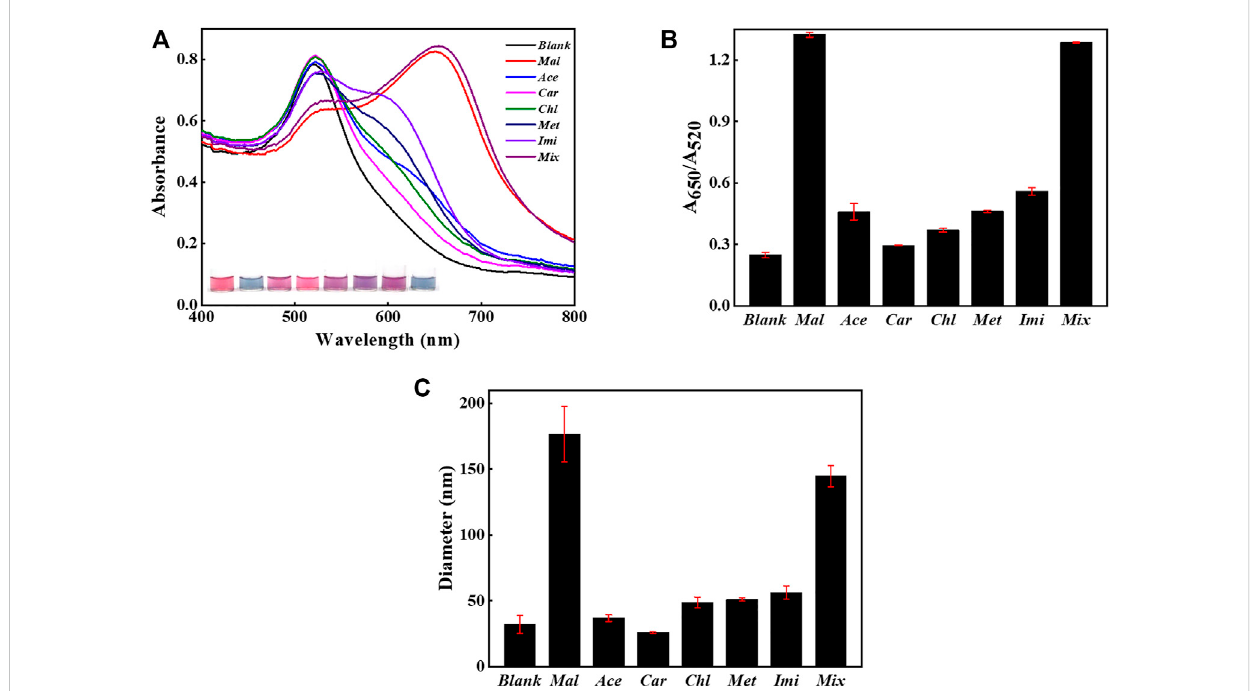
FIGURE 6 Selectivity evaluation. The sensing method when challenged with 1,000 μ g/L non-speci fi c substances alone or coexisting with the presence of 500 μ g/L malathion. (A) The UV-Vis spectra of AuNPs and sample images after the introduction of non-speci fi c analytes with or without the presence of malathion. (B) The values of A 650 /A 520 in different samples. (C) The DLS sizes of AuNPs in different samples. The error bars represent the standard deviation of three independent measurements.